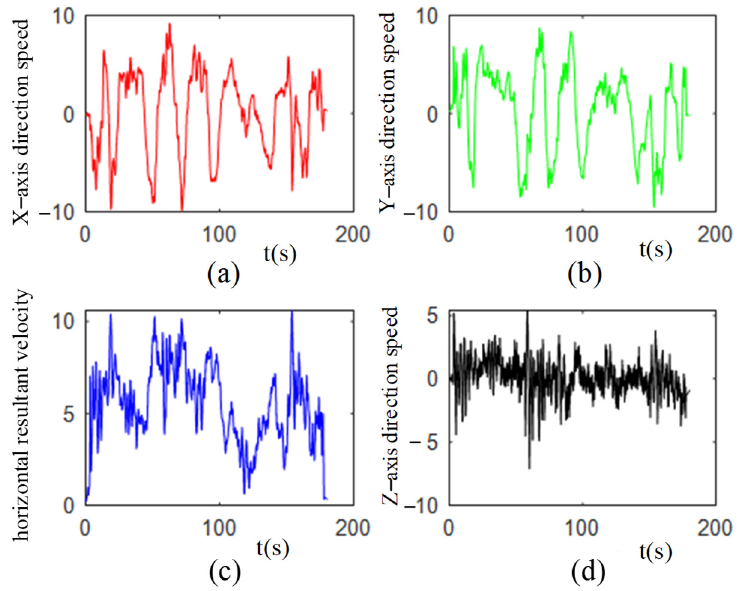
Figure 16. Flight speed variation diagram. ( a ) Speed variation in X direction. ( b ) Speed variation in Y direction. ( c ) Speed variation of horizontal resultant speed. ( d ) Speed variation in Z direction.